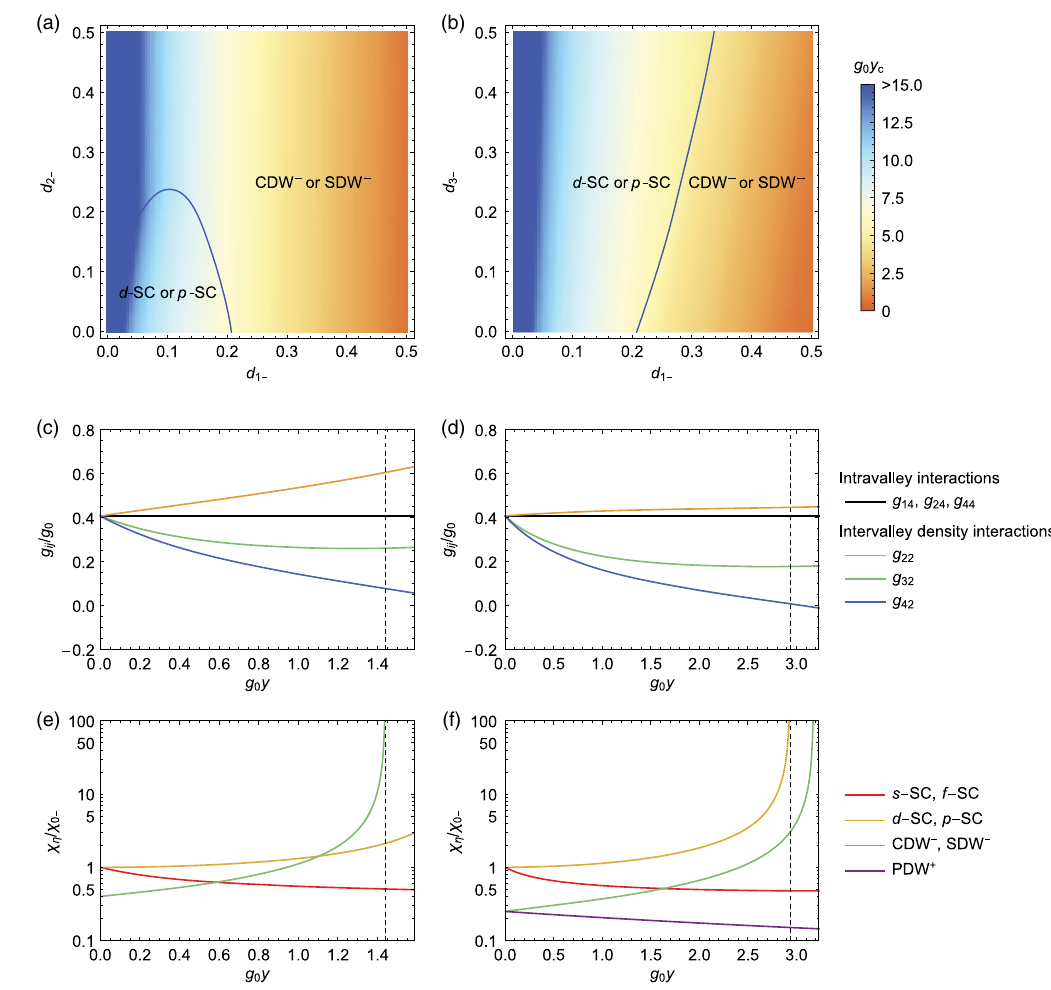
FIG. 4. Phase diagrams with the density-density interactions. (a),(b) Phase diagrams obtained by the RG analysis in the presence of the density-density interactions ( g 14 ¼ g 24 ¼ g 44 ¼ g 22 ¼ g 32 ¼ g 42 ). Two parameters for nesting are varied in each phase diagram: (a) d 1 − and d 2 − ( d 3 − ¼ 0 ) and (b) d 1 − and d 3 − ( d 2 − ¼ 0 ). Colors represent critical RG scales for instabilities: warm (cool) colors correspond to high (low) energy and temperature. The solid lines represent phase boundaries, obtained in the range of g 0 y are CDW 0 or SDW 0 and normal regions in the vicinity of d 1 − ¼ 0 (not shown), but critical temperatures are extremely low for those > 15 ). (c),(d) Running coupling constants and (e),(f) susceptibilities for possible orders. We show the results for two instabilities ( g 0 y c cases with different strength of nesting: (c),(e) d 1 − ¼ 0 . 4 and (d),(f) d 1 − ¼ d 3 − ¼ 0 . 25 . The vertical dashed lines indicate the positions where instabilities